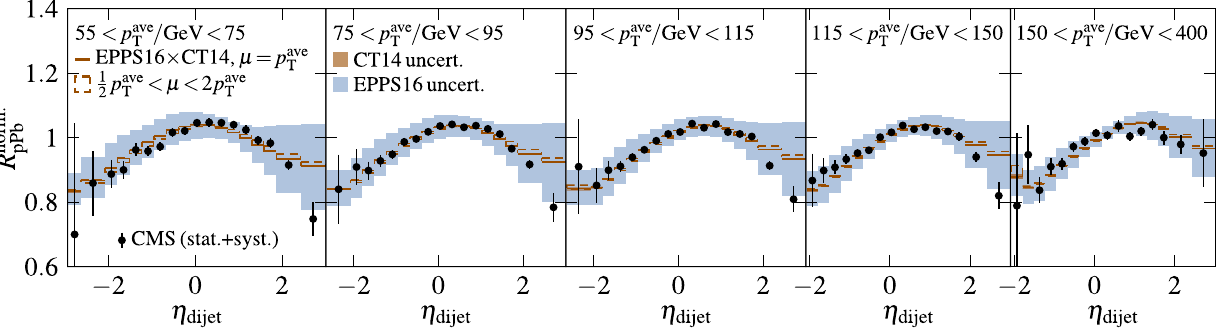
Fig. 9 The nuclear modification ratio of normalized pPb and pp dif- ferential cross sections. Black markers show the data from CMS mea- surement [4] with vertical bars showing the statistical and systematical